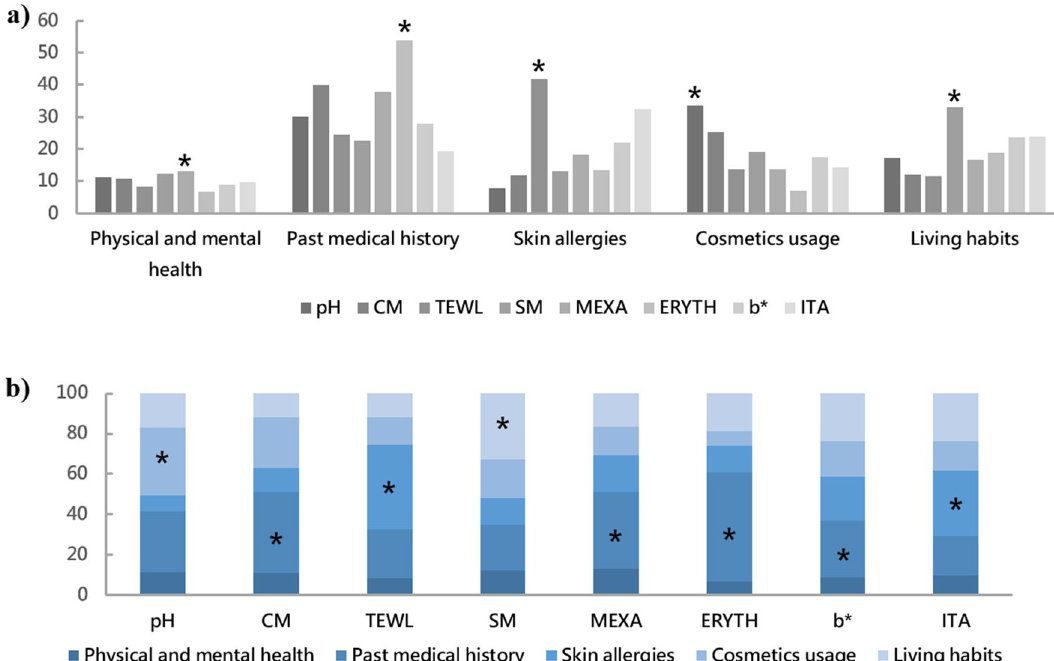
Figure 5. Lateral impacts of individual lifestyle on each skin parameter (%) ( a ). Longitudinal impacts of individual lifestyle on each skin parameter (%) ( b ). *Indicates the maximum value of this group (the Supplementary Materials 1.1 for specific